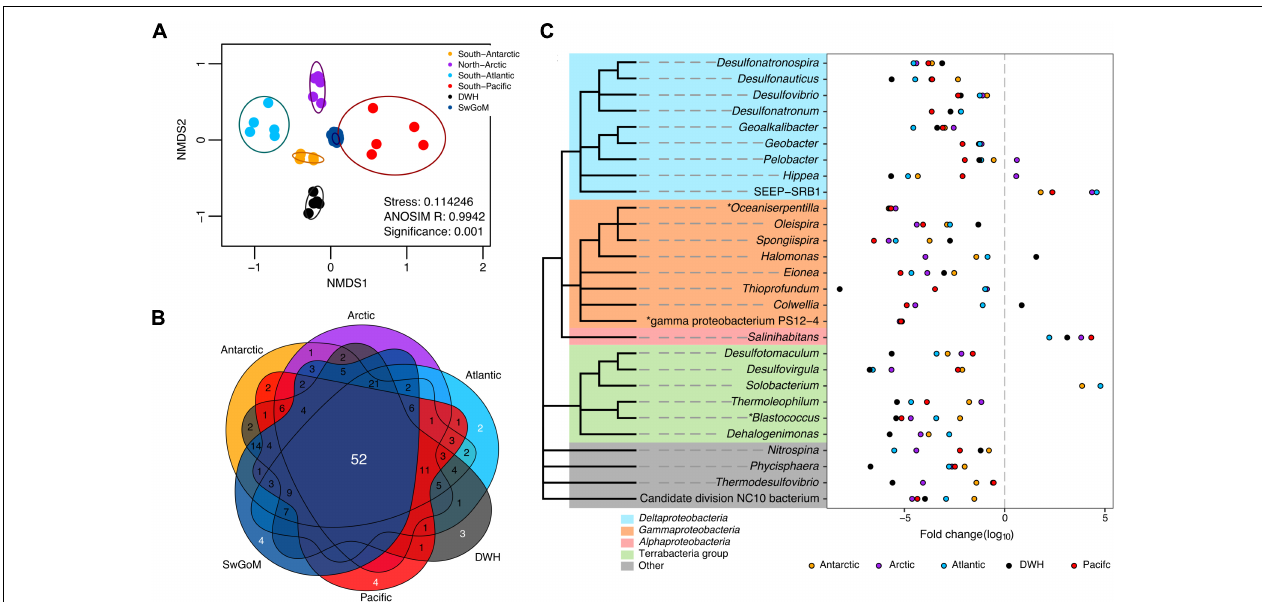
FIGURE 3 | Bacterial diversity and community structure comparison between projects from different sediments in distant geographical sites. (A) Nonmetric multidimensional scaling plot of the Bray–Curtis beta diversity estimated from the abundance matrix at the genus level. Ellipses indicate a confidence = 0.9. (B) Venn diagram comparing the “core” groups of each region with the “core” of the swGoM at the genus level ( > 1% abundance). (C) Fold change of genera identified as differentially abundant in the swGoM. The asterisk mark represents unique genera in the “core” of the swGoM > 1% of abundance. Negative values indicate lower abundance with respect to the swGoM and vice versa . Cladograms represent taxonomic association among phylotypes; but branch lengths do not reflect phylogenetic